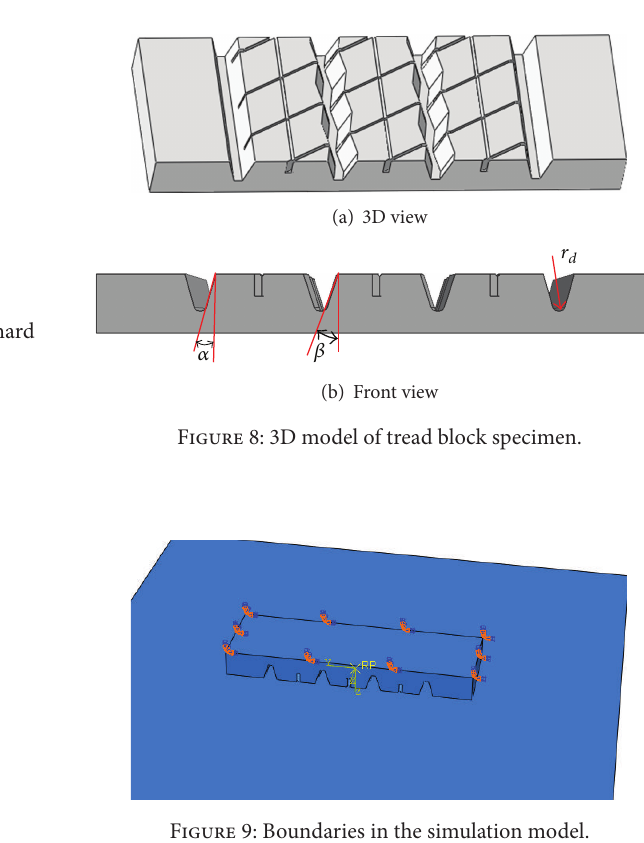
Figure 9: Boundaries in the simulation model.